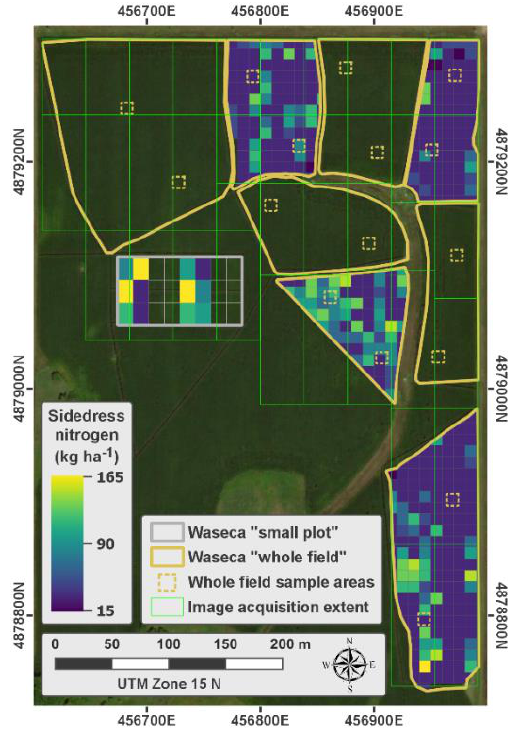
Figure 1. Waseca “small plot” and “whole field” experimental boundaries. The whole field sample areas, whole-field hyperspectral image extents, and sidedress N fertilizer rates are also illustrated.